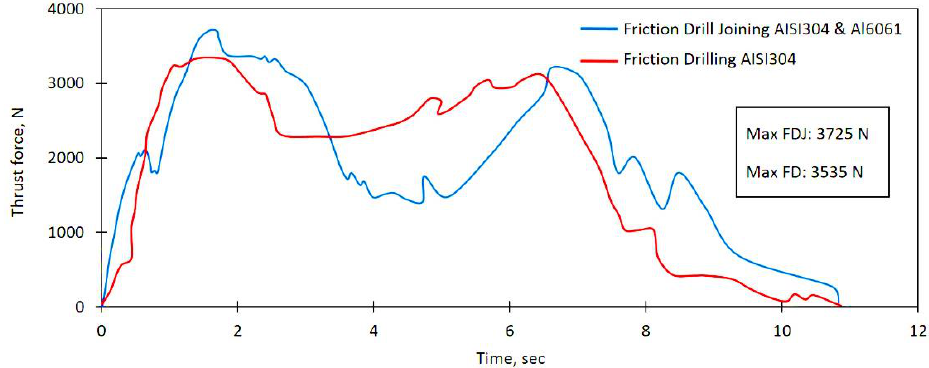
Figure 10. Comparison of required thrust force for friction drilling and friction drill joining process.